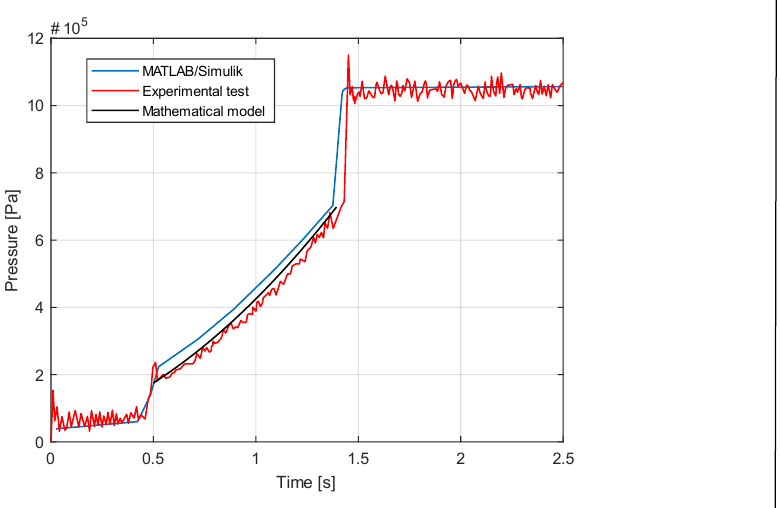
Figure 7 – Comparative presentation of the results obtained Рис. 7 – Сравнительный обзор полученных результатов Слика 7 – Упоредни приказ добијених резултата